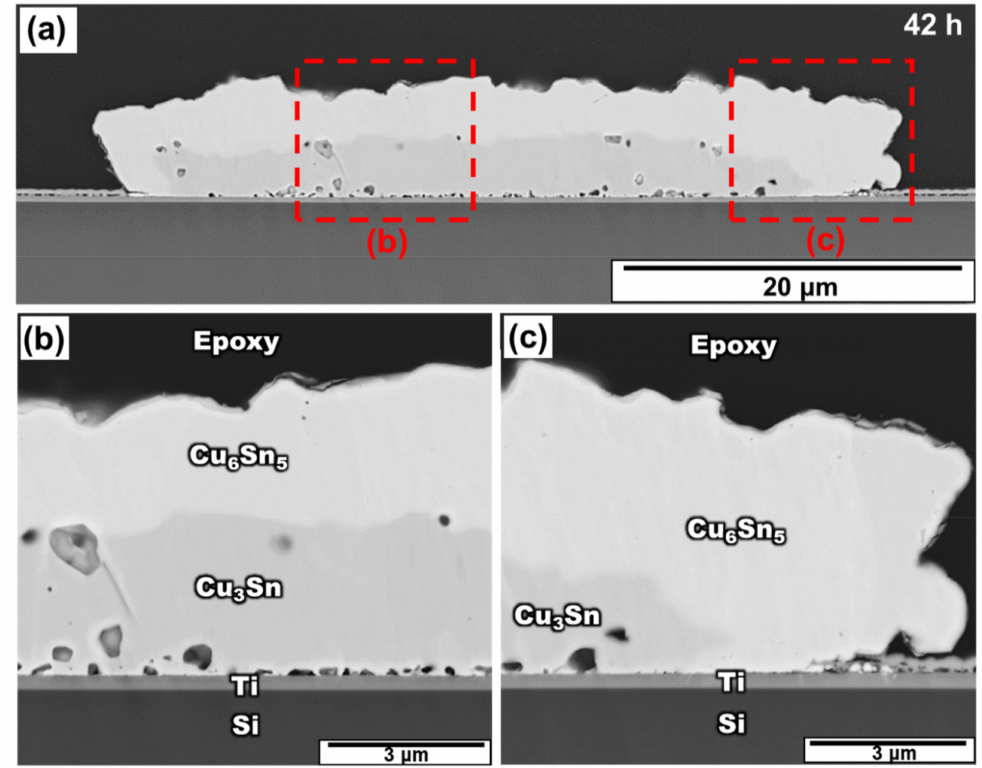
Figure 5. ( a ) Cross-section SEM image of the Sn/Cu micro-bump after aging at 200 ◦ C for 42 h and the zoomed-in image in a region near the ( b ) middle region and ( c ) right edge.